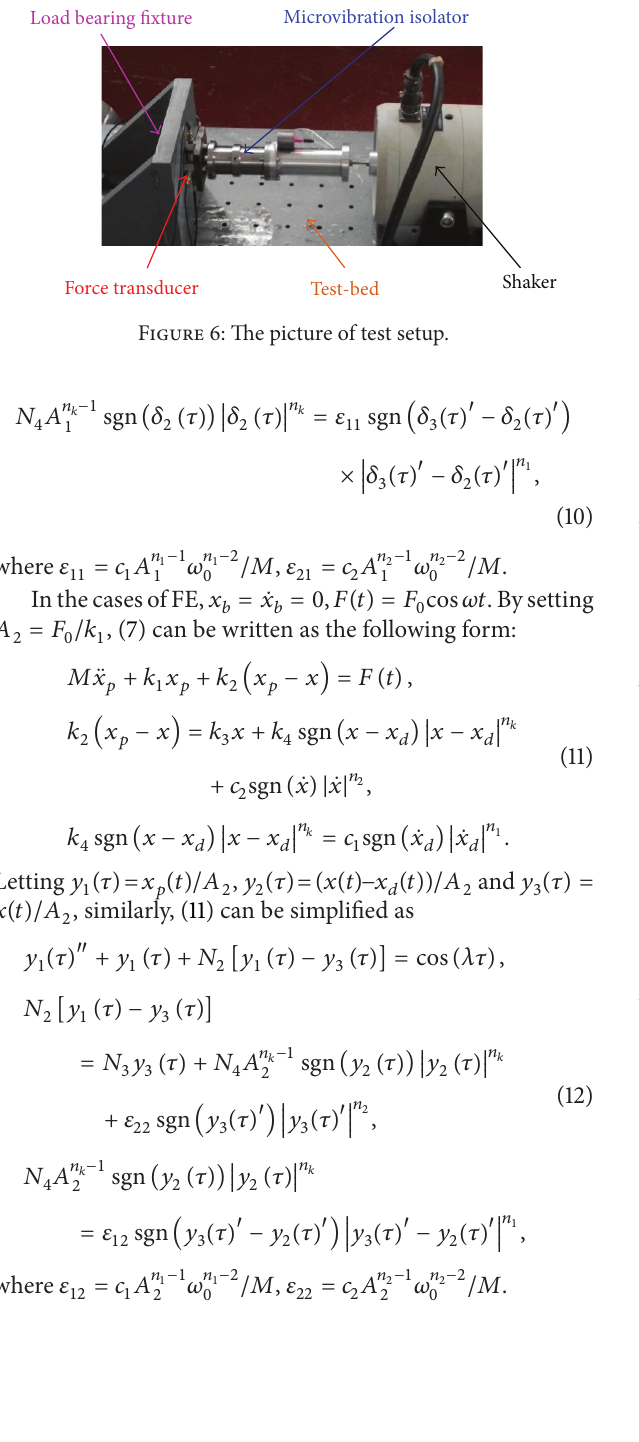
Figure 7: The schematic diagram of the test setup of force transmis-